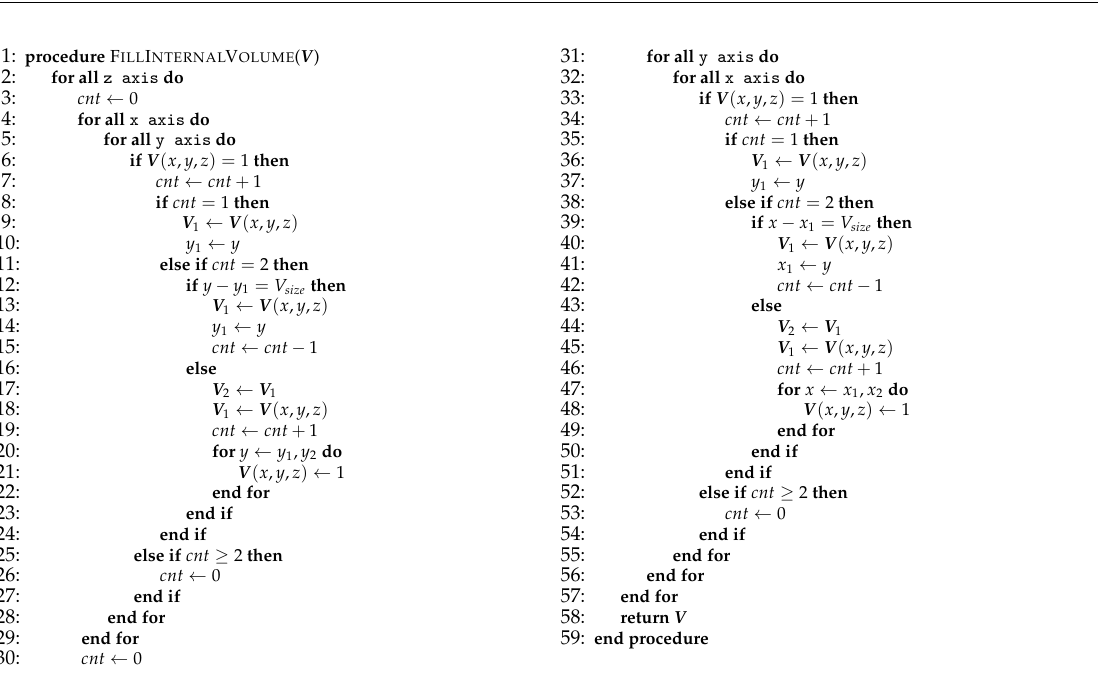
Algorithm 1 Algorithm for supplementing an object shell voxel map with internal volume